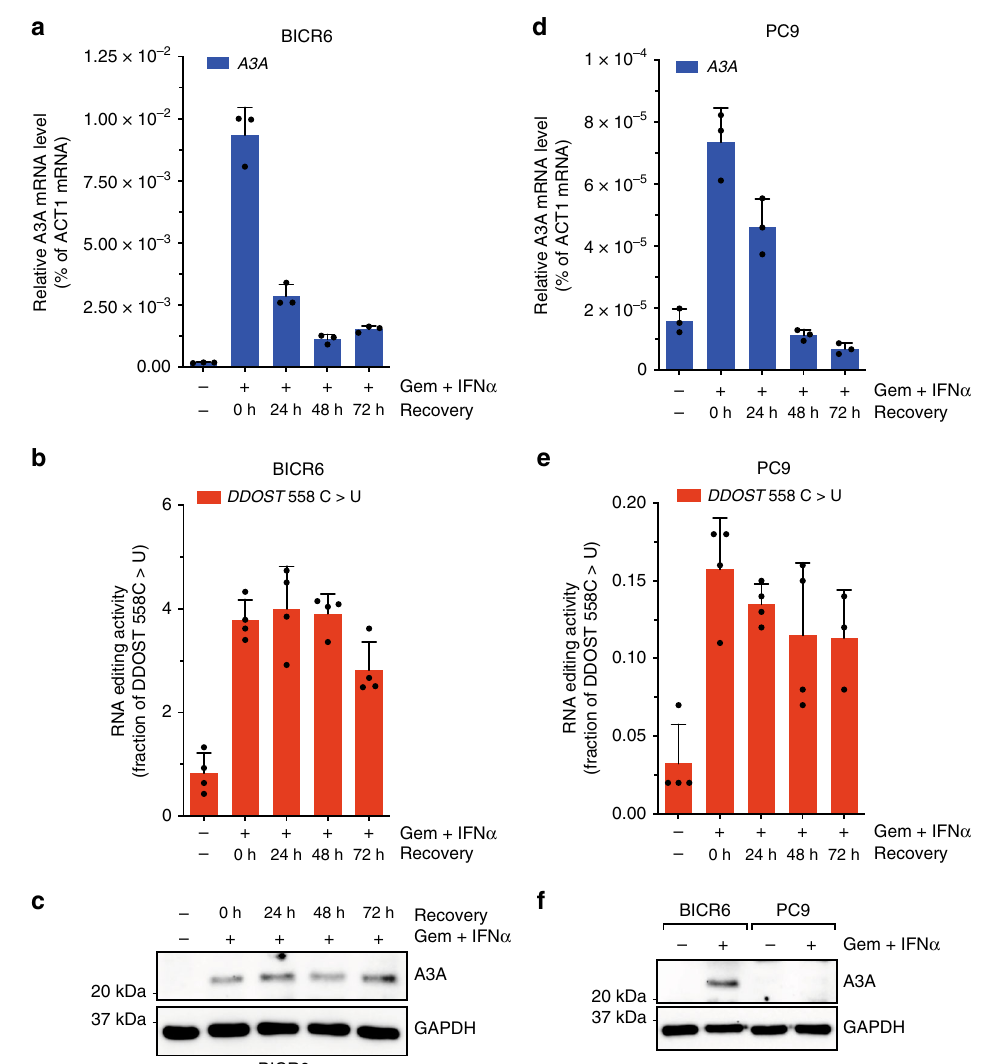
Fig. 6 RNA mutation-based ddPCR assay is the most accurate method to monitor APOBEC3A level in cancer cells. a – f Level of A3A was monitored by RT-qPCR, ddPCR, and western blot in BICR6 or PC9 cells following treatment with Gemcitabine (0.5 μ M) and Interferon- α A/D (750 U ml − 1 ) for 48 h and release into drug-free media for 24 h, 48 h or 72 h. Error bar: S.D. ( n ≥ 3). Source data are provided as a Source Data fi